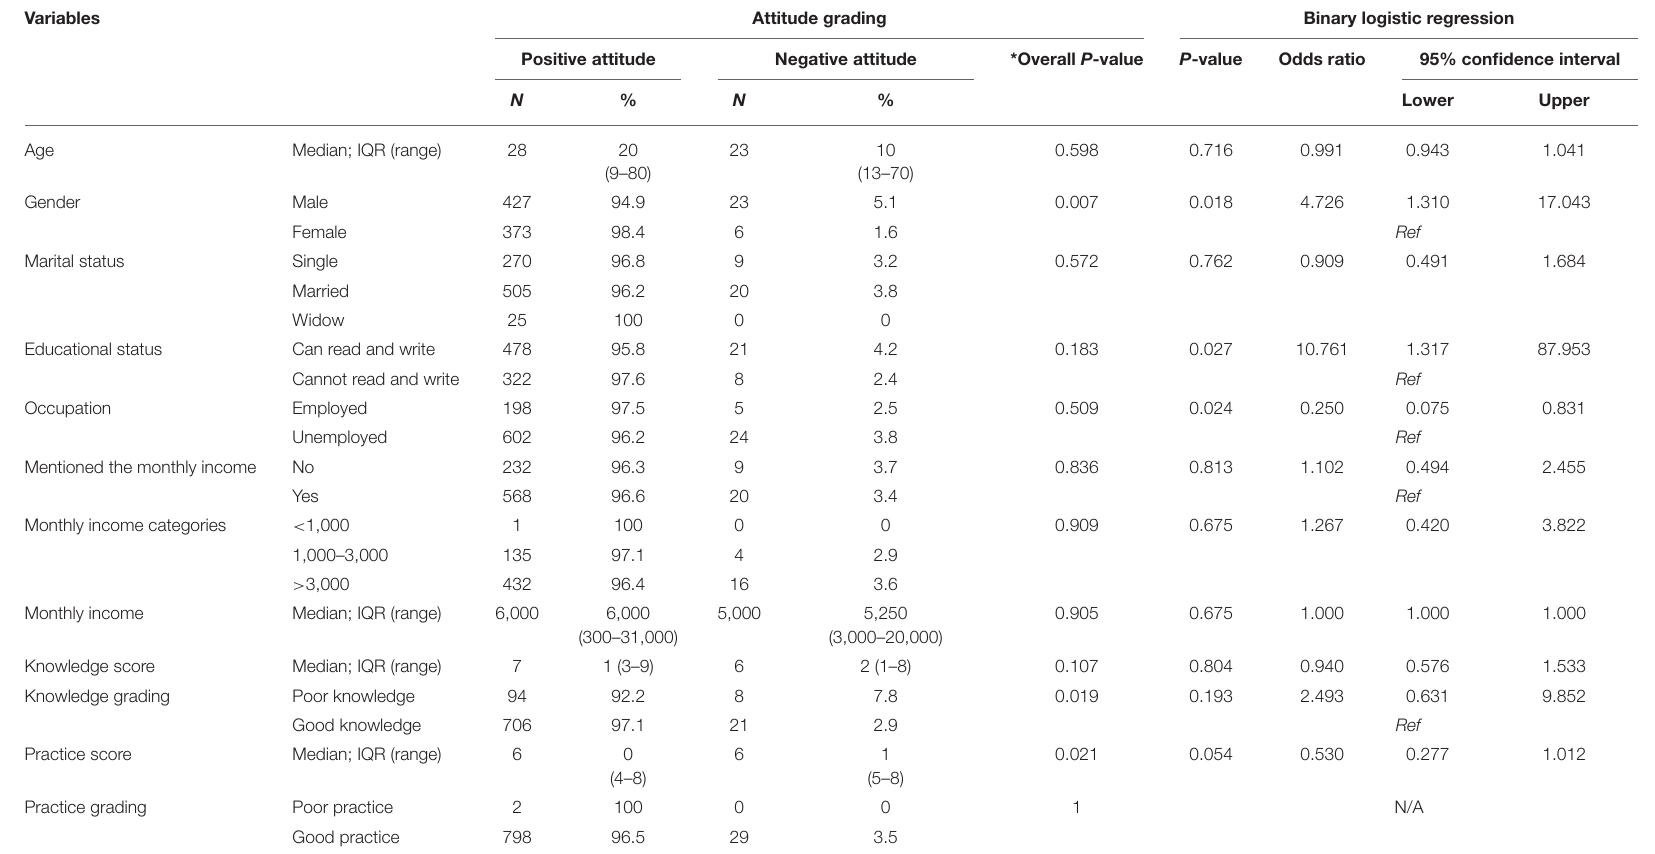
TABLE 4 | Attitude and associated factors ( N = 829